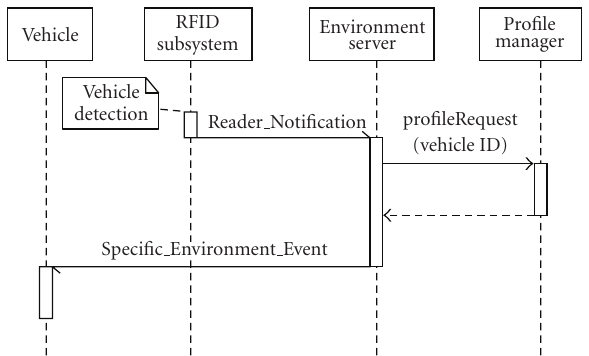
Figure 3: Sequence diagram for adapting contextual